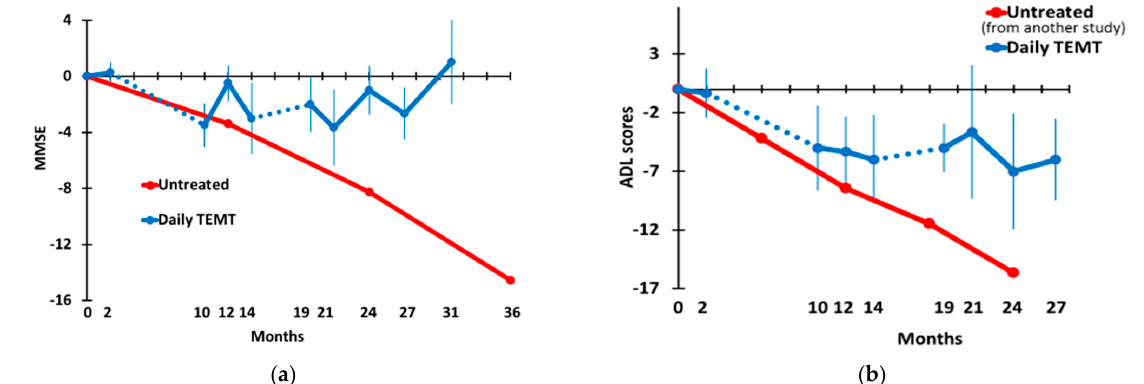
Figure 5. ( a ) Mini-Mental State Exam (MMSE) and ( b ) Activities of Daily Living (ADL). Dotted lines indicate the 8M and 5M periods of no treatment. For both the MMSE and ADL graphs, the red data points are from earlier clinical studies evaluating these two measures longitudinally in untreated mild/moderate AD subjects. SEMs were not available from either earlier study.